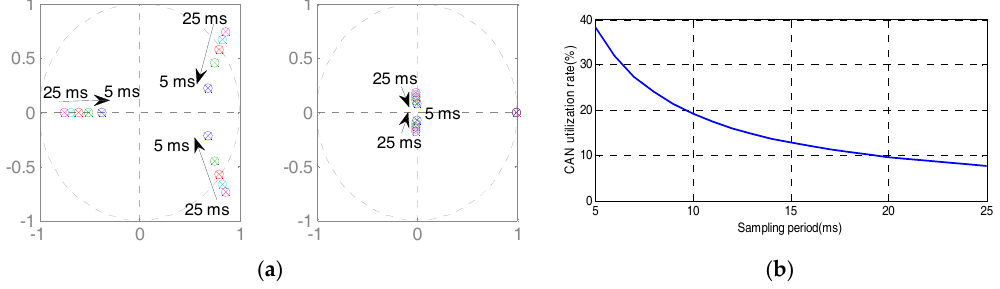
Figure 5. Results with different sampling periods: ( a ) System pole map with different sampling periods; and ( b ) Utilization rates with different sampling periods.